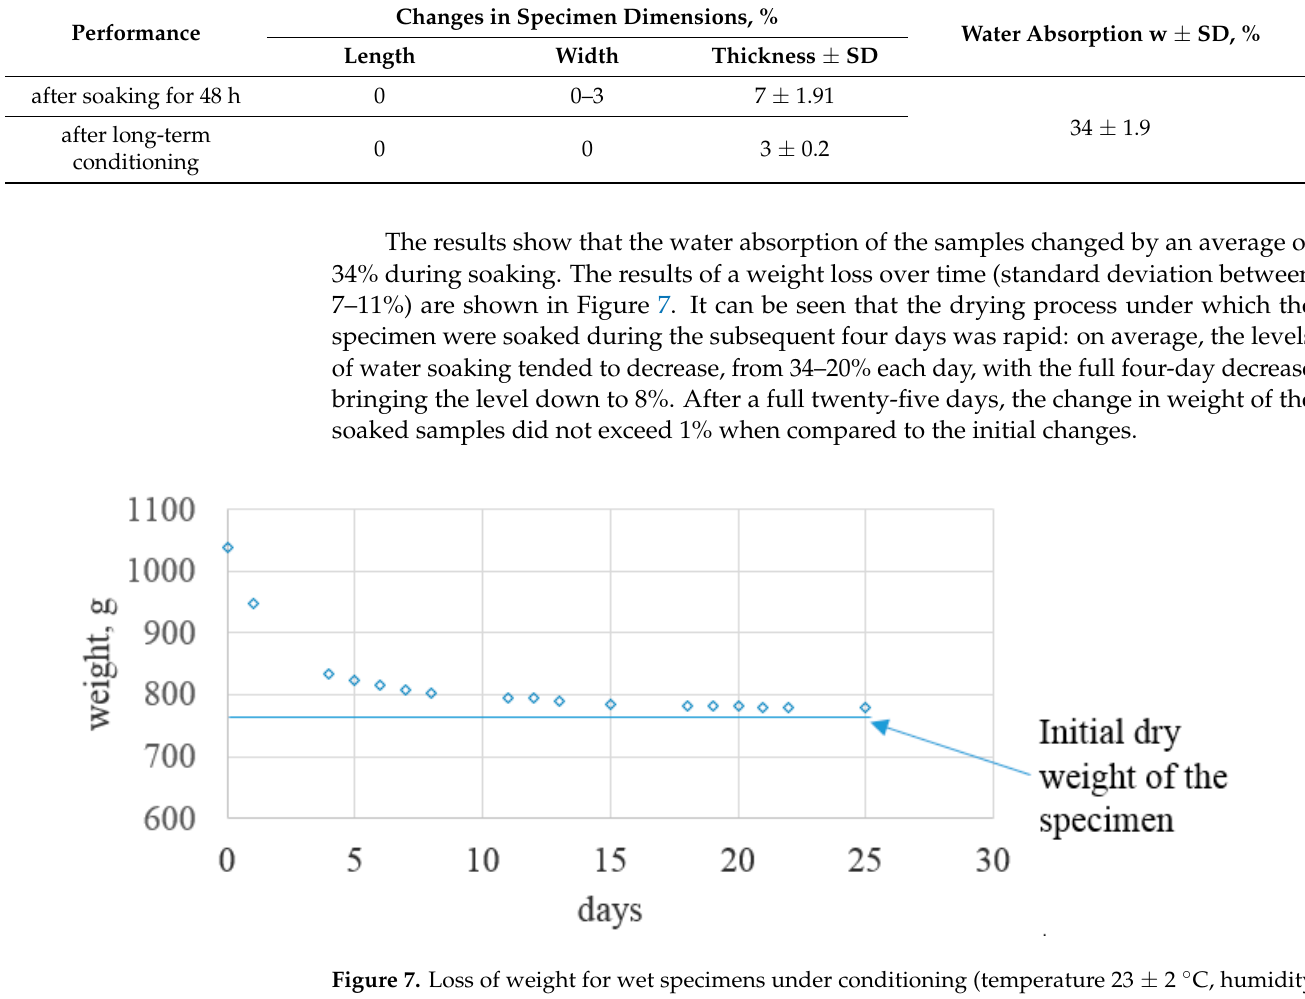
Table 2. The results of dimensional changes in the specimens and water absorption levels.